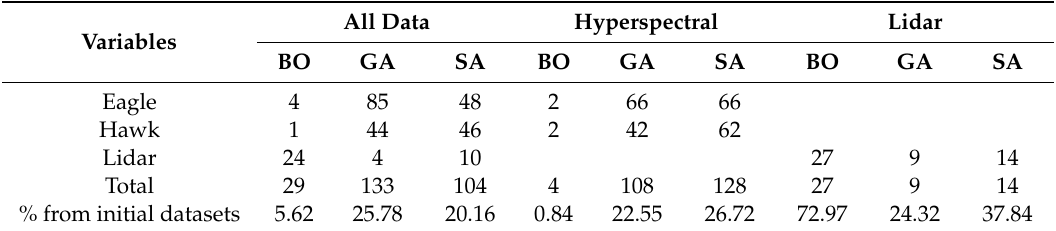
Table 4. Number of significant variables identified from the feature selection